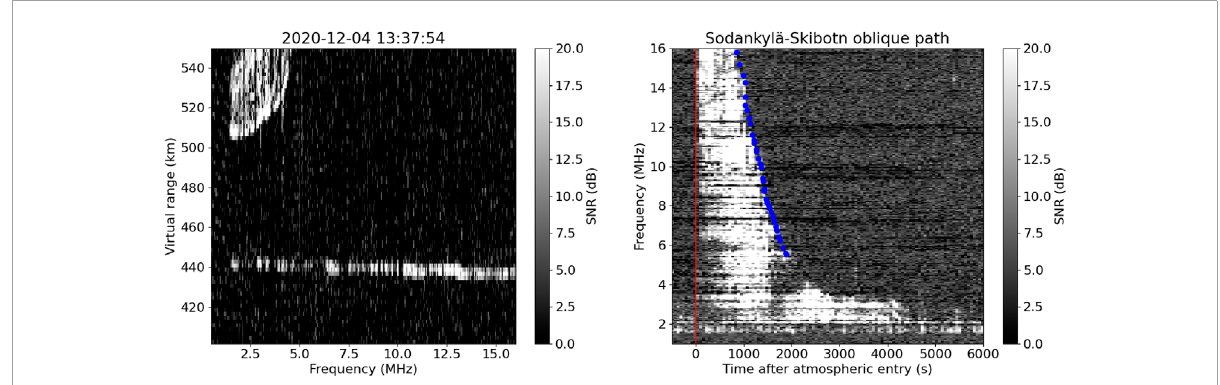
FIGURE 14 Left: The sporadic E trace that appeared after the fireball entry in the Sodankylä-Skibotn oblique ionogram. The horizontal trace at a virtual range of 440 km corresponds to the echoes from the meteor trail. The trace above 500 km is due to F-region O- and X-mode reflections. Right: maximum signal-to-noise ratio between 420-460 km as a function of time and frequency. The red line indicates the entry time of the fireball. The blue dots indicate points used to measure the decay rate of the cutoff